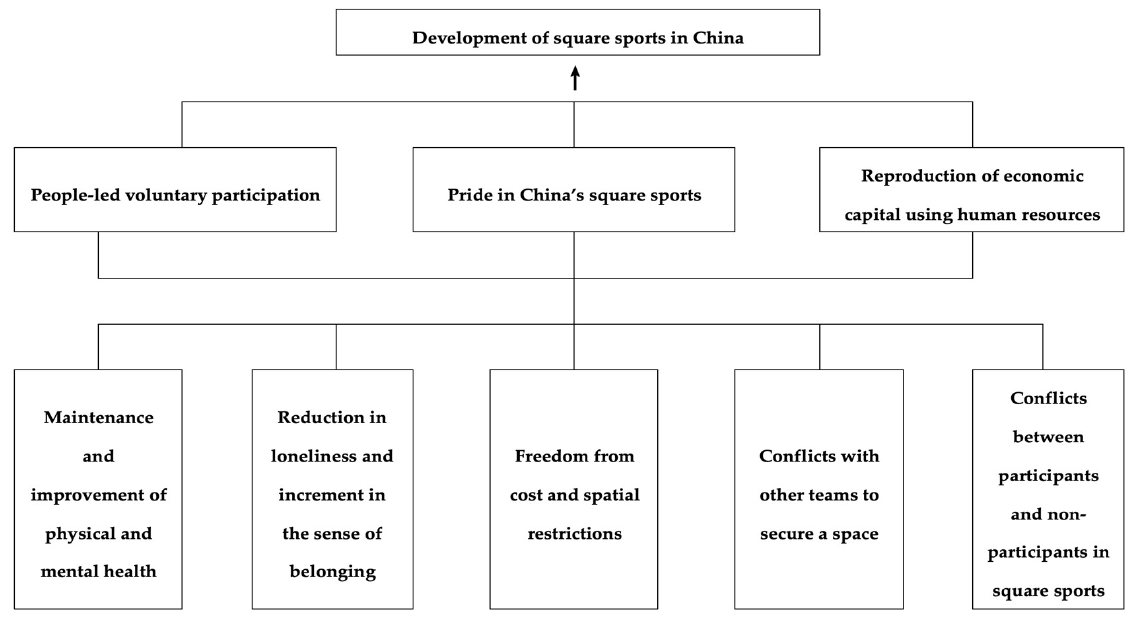
Figure 1. Presentation of Results.